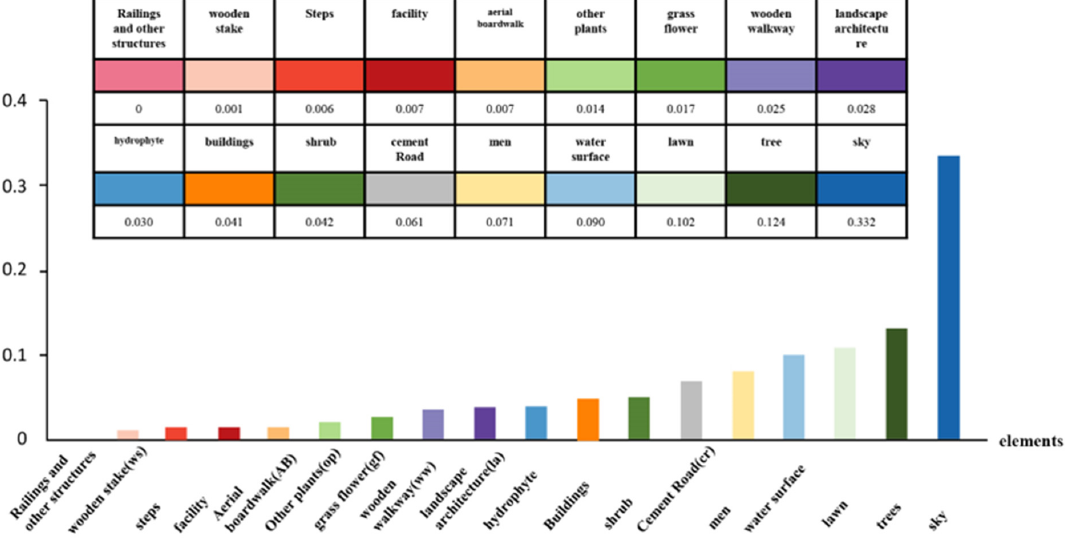
Figure 4. Focus on landscape elements in the four seasons (F1: the element with the highest attention from tourists, S2: the element with relatively little attention, T3: the element with little attention).